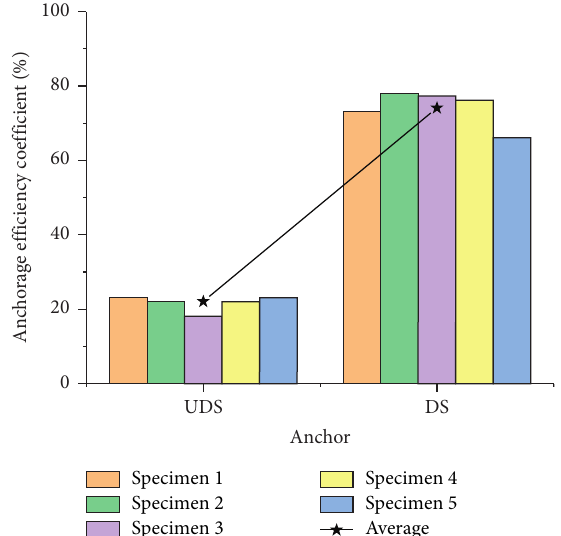
Figure 20: Comparison of anchorage efficiency between dissolution-rebond anchor and traditional bond